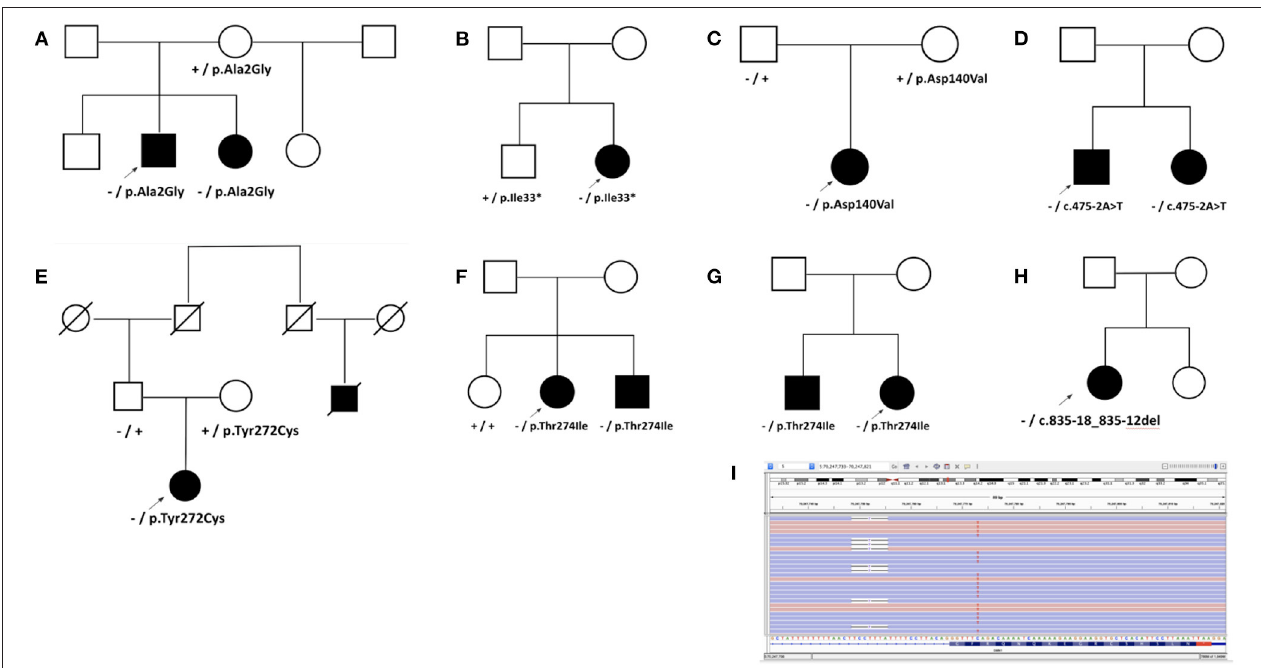
FIGURE 3 | Analysis of pedigrees. Pedigrees were developed for families with nearly diagnostic sequence variants identified in probands undergoing SMA testing when additional clinical information was provided. Heterozygous deletion of SMN1 is noted by “–,” while “ + ” denotes wild type. Sequence variants are noted by HGVS nomenclature. (A) Family A with p.Ala2Gly. The proband presented with delayed ambulation in childhood, had progressive weakness, and became wheelchair bound by his teenage years. His sister had similar muscle weakness as well as both variants. A brother and a maternal half-sister reported no weakness but were